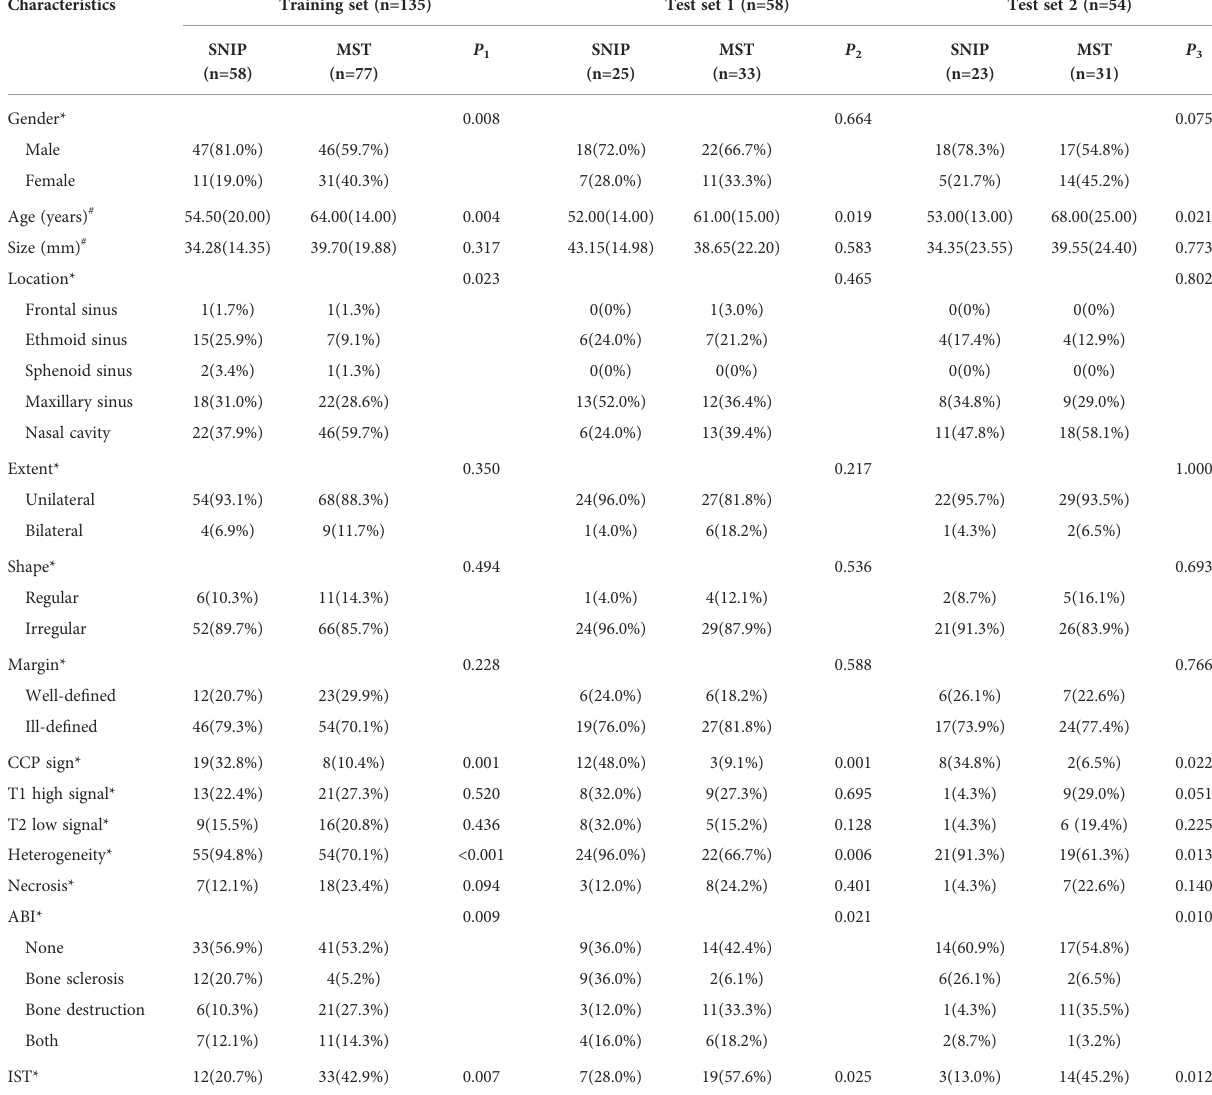
TABLE 2 Analysis result of the clinic – radiological features between SNIP and